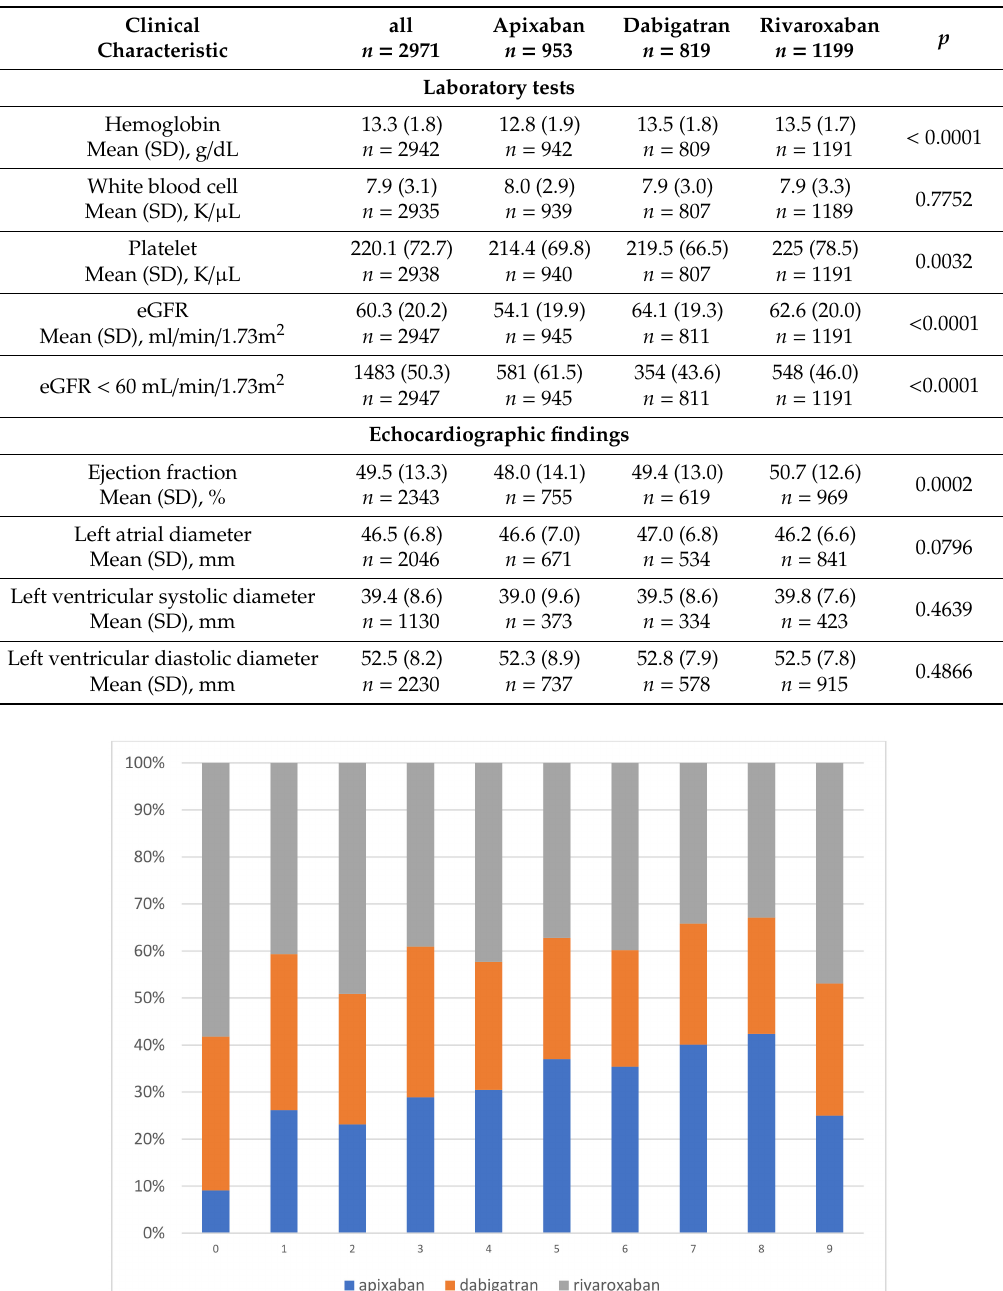
Table 2. Results of the laboratory tests and echocardiographic examinations of patients treated with apixaban, dabigatran, and rivaroxaban. The numbers are presented as the mean ± standard deviation, or numbers (percentage) otherwise mentioned. Abbreviations: eGFR, estimated glomerular filtration rate; SD, standard deviation.